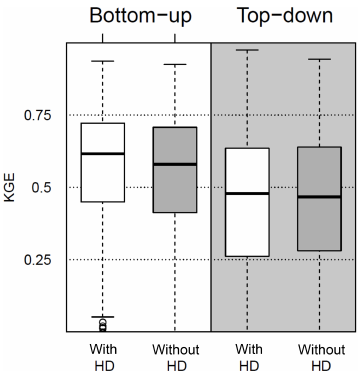
Figure A1. Comparison of the simulation results obtained with and without hydrological downscaling (HD) of the initial conditions by the modelling chains based on either the bottom-up or the top-down configuration. HD slightly increased both the best and average per- formance of the model